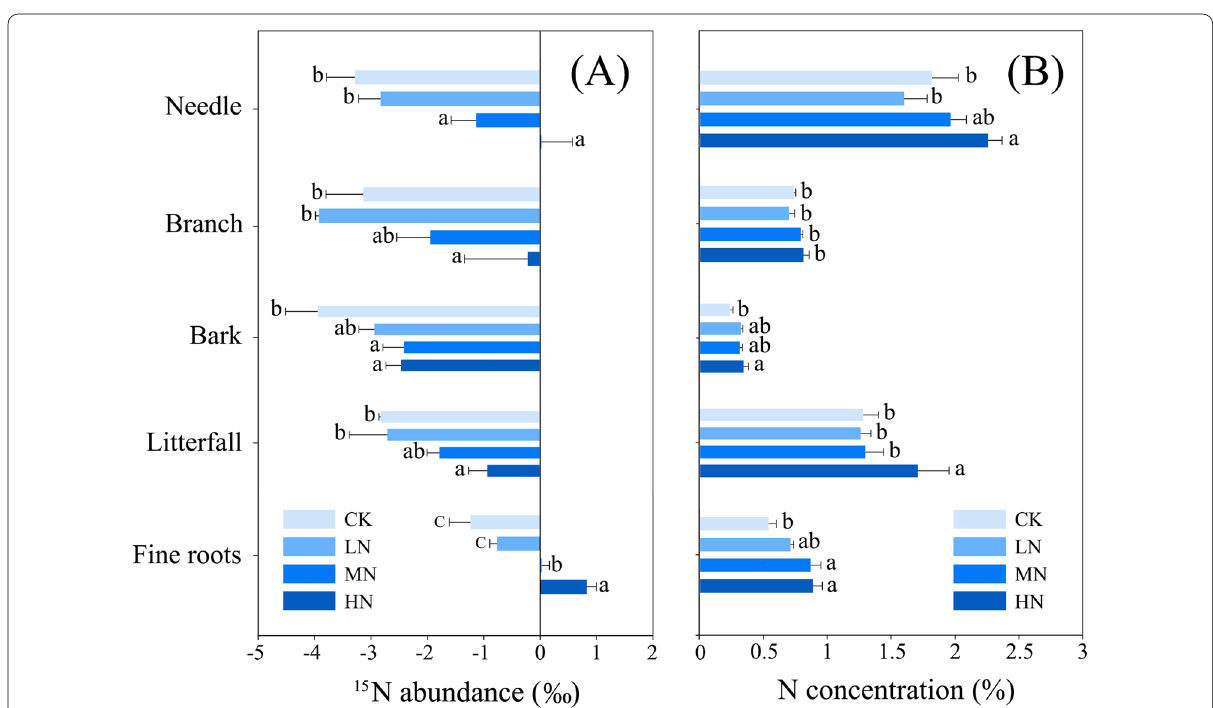
Fig. 2 Effects of nitrogen addition on δ 15 N value and N concentration of different components of Larix gmelinii. A The δ 15 N value of different components of Larix gmelinii . B The N concentration of different components of Larix gmelinii . Error bars represent 1 SE of the mean. CK, LN, MN, HN represent the control, low N treatment, medium N treatment, and high N treatment,